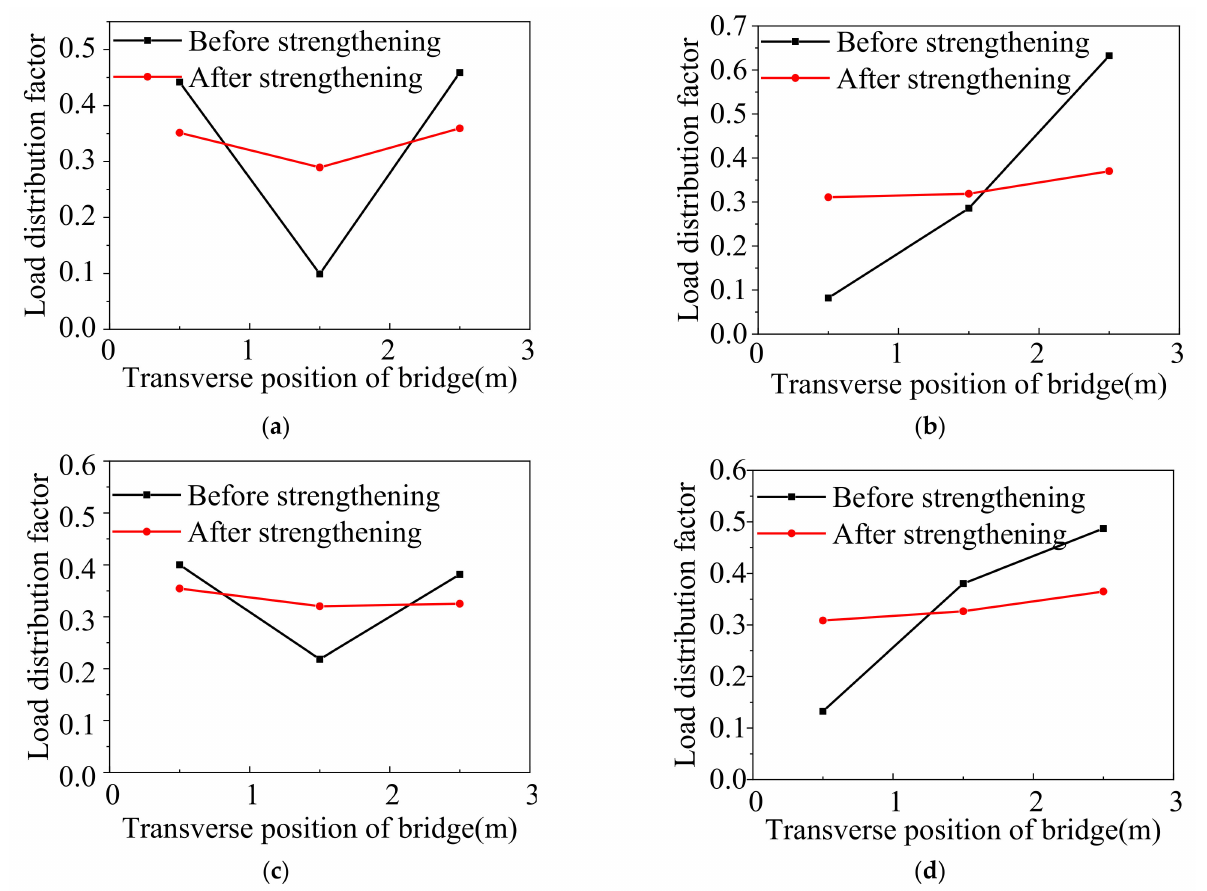
Figure 14. Lateral load distribution factor from field tests. ( a ) Deflection distribution factors under symmetrical load. ( b ) Deflection distribution factors under partial load. ( c ) Strain distribution factors under symmetrical loading. ( d ) Strain distribution factors under partial